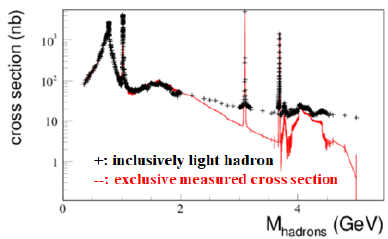
Figure 4. The cross section for light hadron production, where black points with errors are total hadronic cross section [1], and histogram is sum of measured cross sections for exclusive